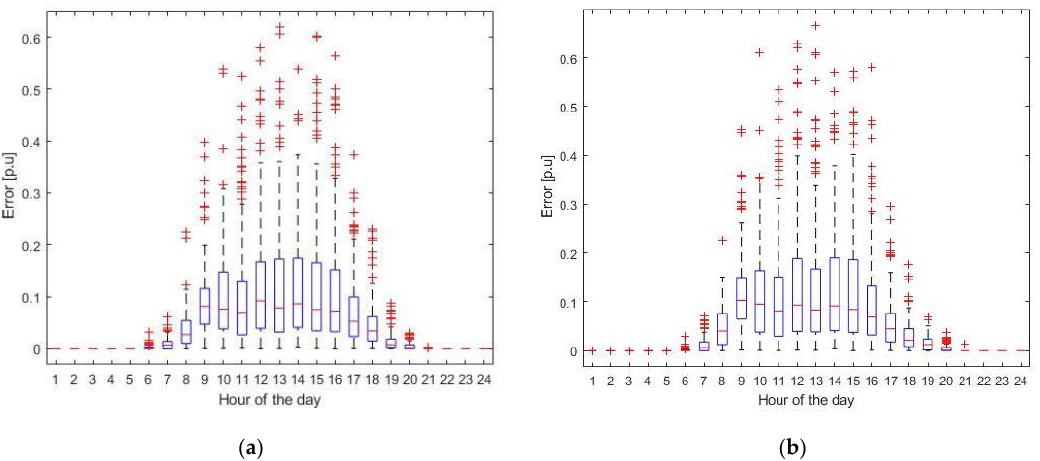
Figure 8. Boxplot of the absolute relative error for each hour of the day. ( a ) Results for Plant 1; ( b ) results for Plant 2.